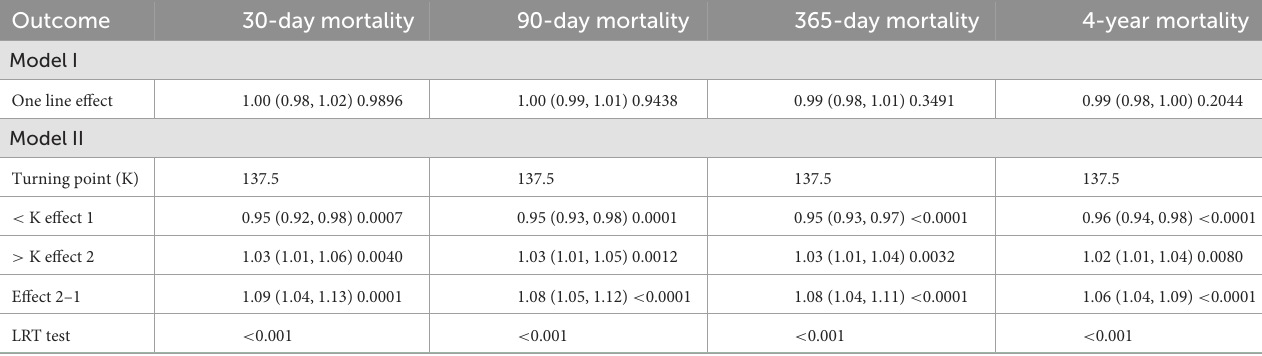
TABLE 2 Threshold effect analysis for the relationship between serum sodium levels and all-cause